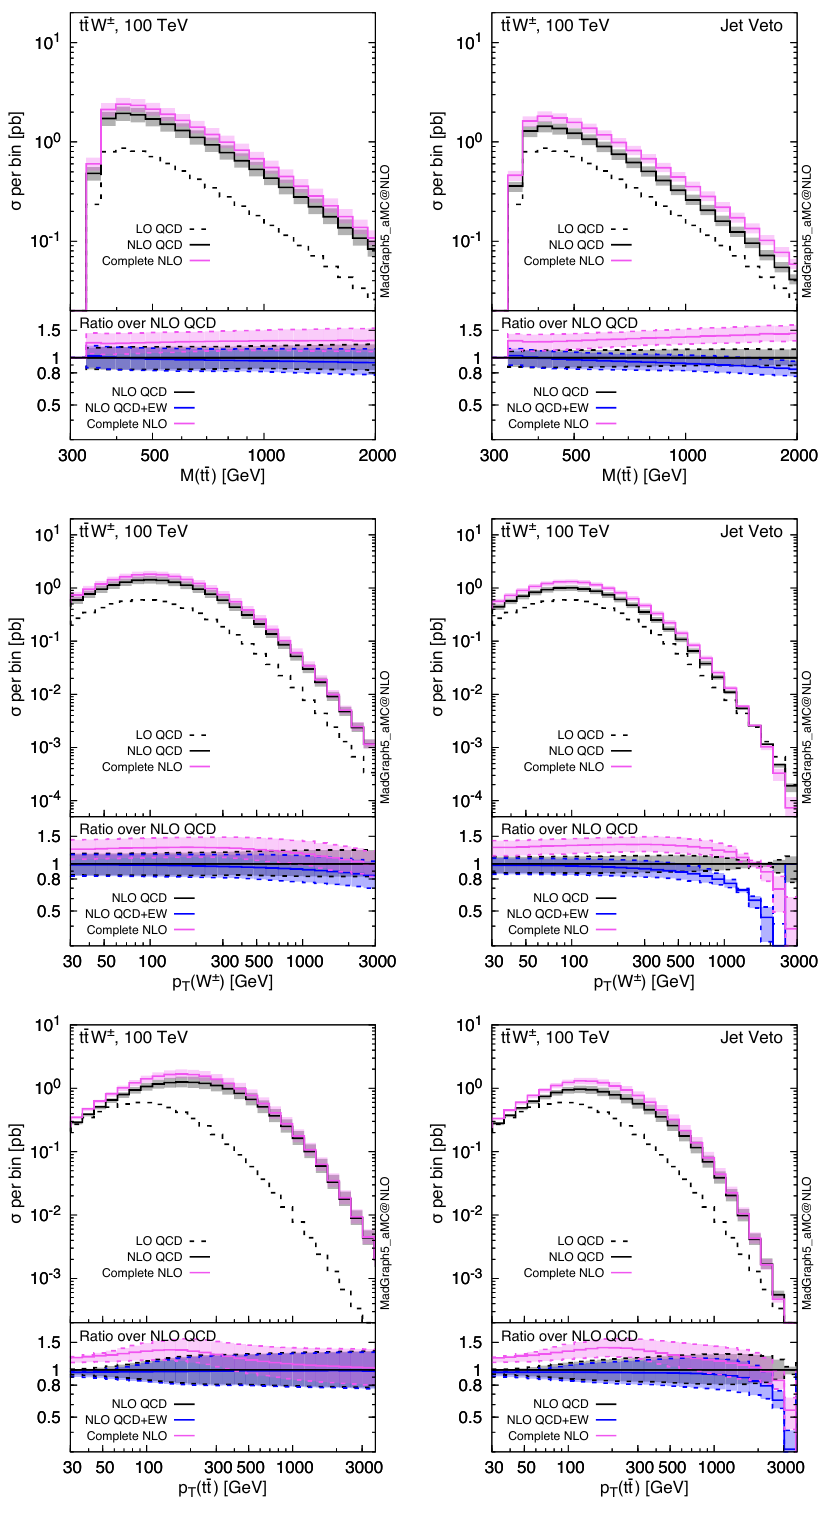
Figure 6 . Same as (cid:12)gure 5 but for 100 TeV